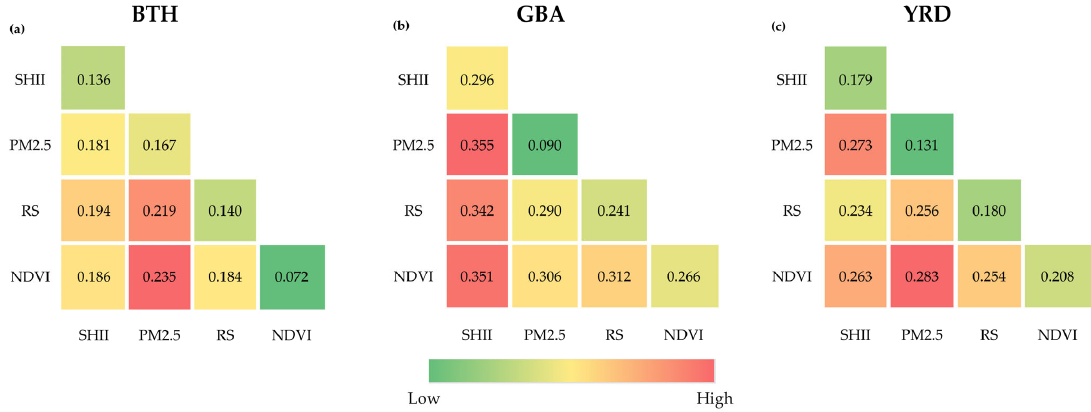
Figure 14. The q ‐ statistic coefficients for the grading indicators in the three UAs.